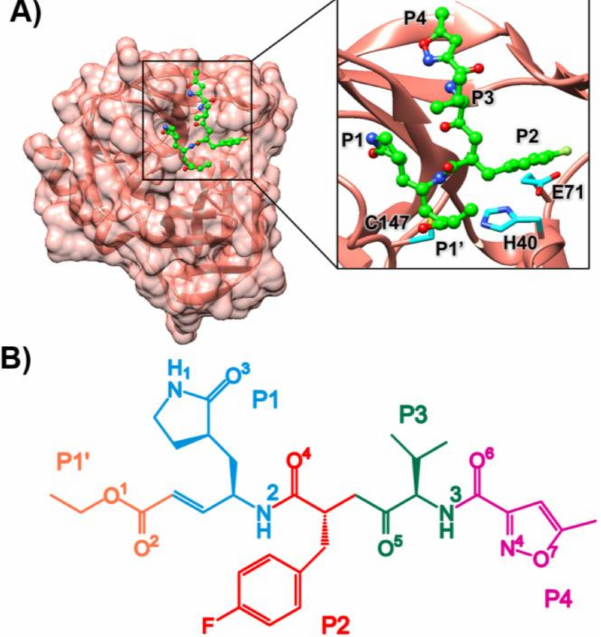
Figure 1. ( A ) The 3D structure of EV-A71 3Cpro in complex with rupintrivir (PDB ID: 3R0F) [27] (ball and stick green model), where the catalytic triad are shown in blue stick model. ( B ) The chemical structure of